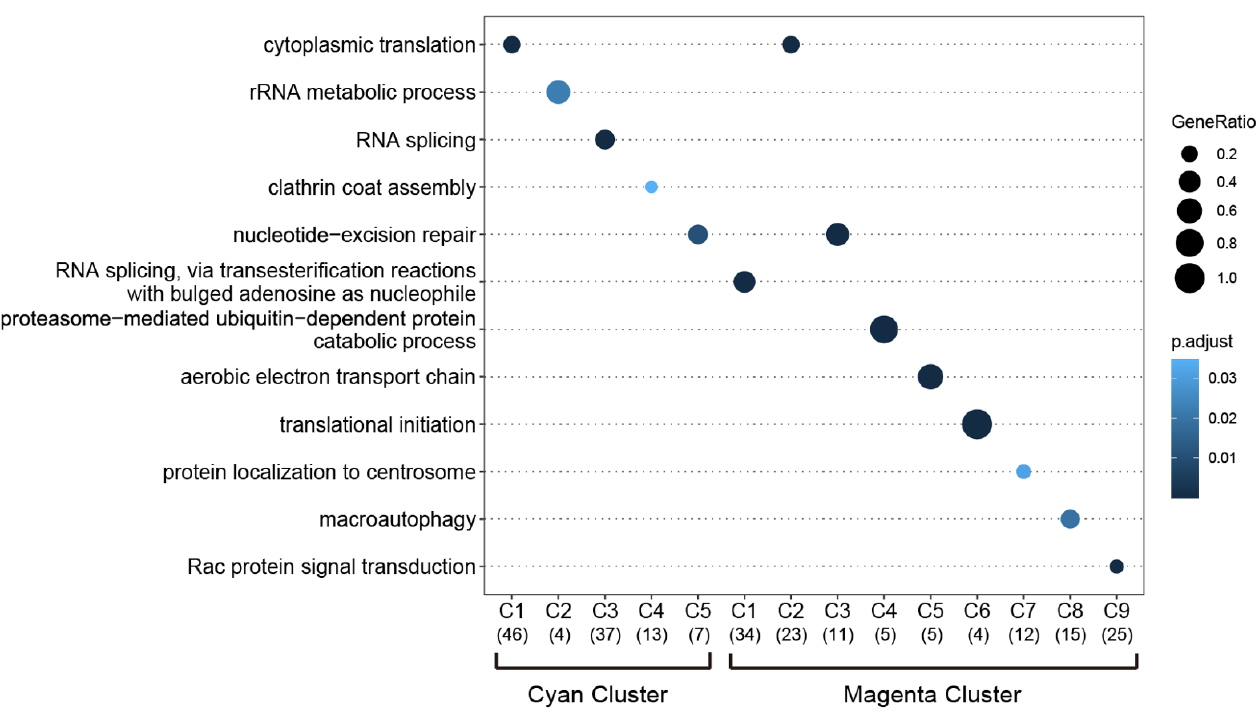
Figure 7. The results of the GO biological process enrichment analysis of the genes identified in the cyan-associated and magenta-associated PPI clusters. The most over-represented GO terms are depicted as dot plots; the gene ratio is denoted by size, and the significance is indicated by color.